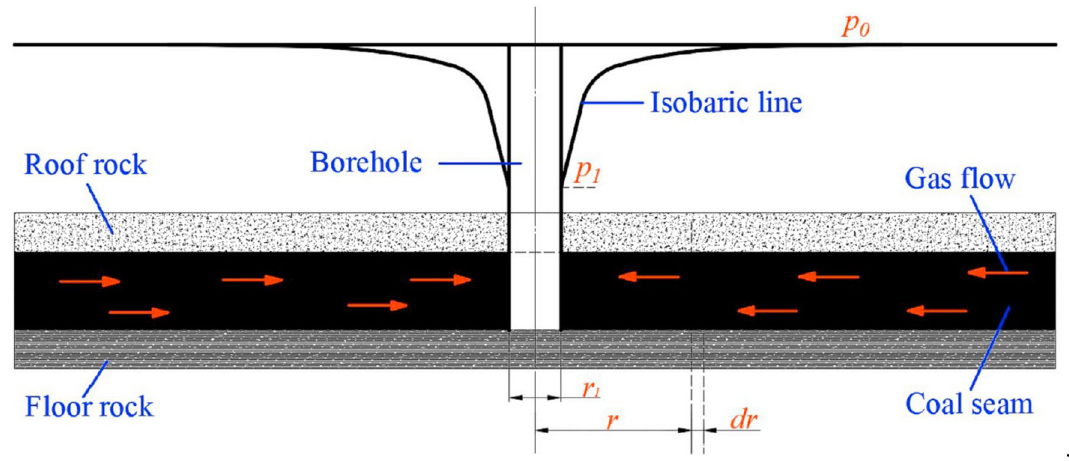
Figure 4. Distribution of radial flow gas pressure in homogeneous coal seam (modified after 33